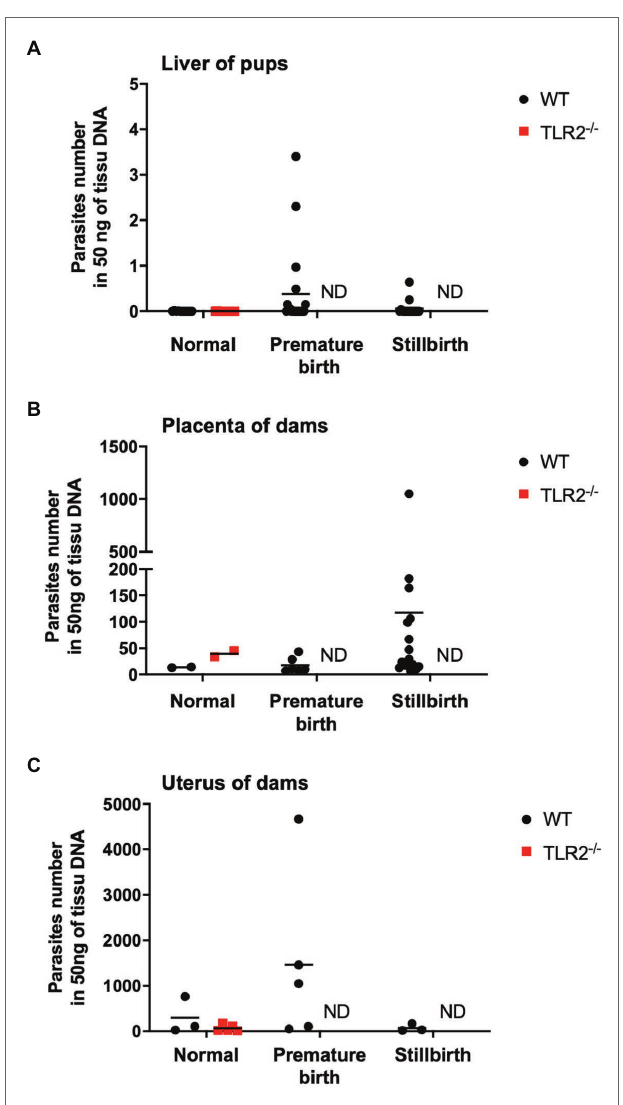
FIGURE 3 | Quantification of the numbers of parasites in the livers of pups and the placentas and uteri of dams. Numbers of parasites in the livers of pups (A) , placentas of dams (B) , and uteri of dams (C) from infected wild- type (WT) and TLR2 − / − mice were analyzed with quantitative PCR. Each point on the graph represents one tissue, and the horizontal lines indicate the mean values for each group. (A) Normal birth: WT ( n = 11), TLR2 − / − ( n = 14); premature birth: WT ( n = 20), TLR2 − / − ( n = 0); stillbirth: WT ( n = 15), TLR2 − / − ( n = 0). (B) Normal: WT ( n = 2), TLR2 − / − ( n = 2); premature birth: WT ( n = 6), TLR2 − / − ( n = 0); stillbirth: WT ( n = 16), TLR2 − / − ( n = 0). (C) Normal: WT ( n = 3), TLR2 − / − ( n = 5); premature birth: WT ( n = 5), TLR2 − / − ( n = 0); stillbirth: WT ( n = 3), TLR2 − / − ( n = 0). Statistical analysis of normal birth samples was performed with the Mann–Whitney U test or t test, but no differences were detected. ND: not done because no sample was